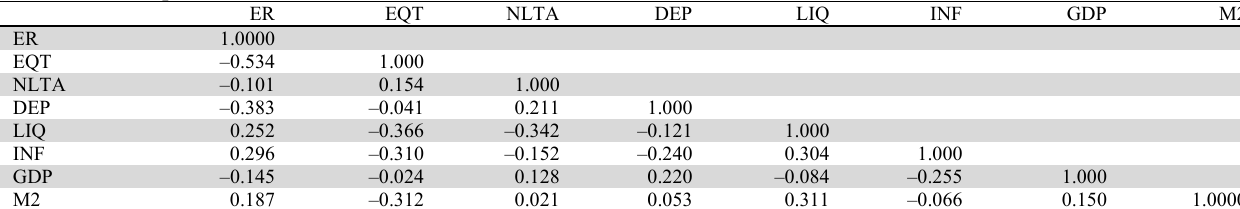
Correlation of dependent